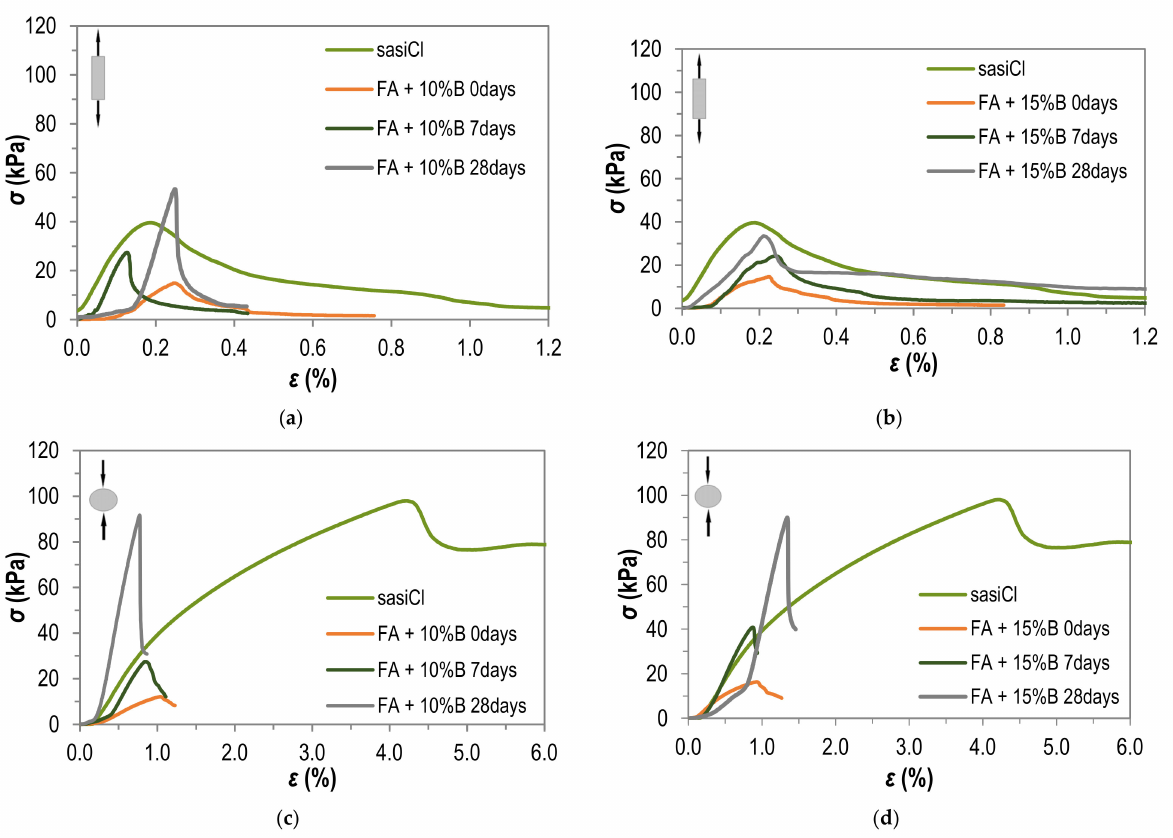
Figure 6. Tensile strength of sandy silty clay (sasiCl) and fly ash with 10% (FA + 10%B) and 15% (FA + 15%B) addition of bentonite tested after different curing times by: ( a , b ) direct method; ( c , d ) in- direct